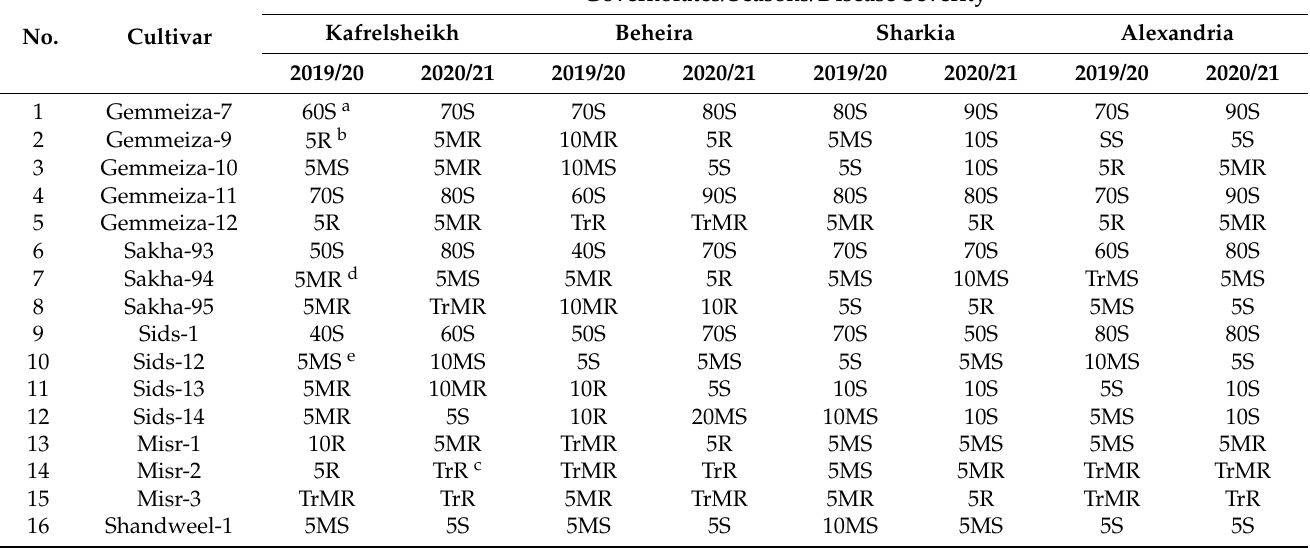
Table 2. Disease severity (%) of 16 Egyptian wheat cultivars of leaf rust in four governorates, during 2019/20 and 2020/21 growing